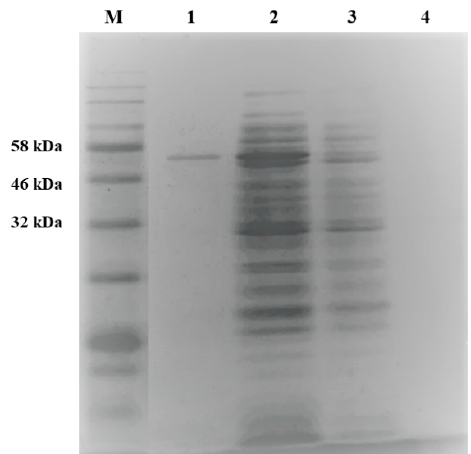
Figure 2. SDS-PAGE analysis and purification of the recombinant levansucrase-Acma. Lane 1, purified levansucrase-Acma by BEM particles; Lane 2, the soluble crude enzymes extracted from the recombinant E. coli BL21 (DE3) cells after IPTG induction; Lane 3, purified supernatant; Lane 4, BEM particles.